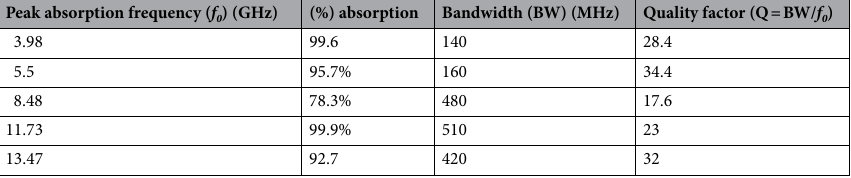
Peak absorption frequency ( f 0 )